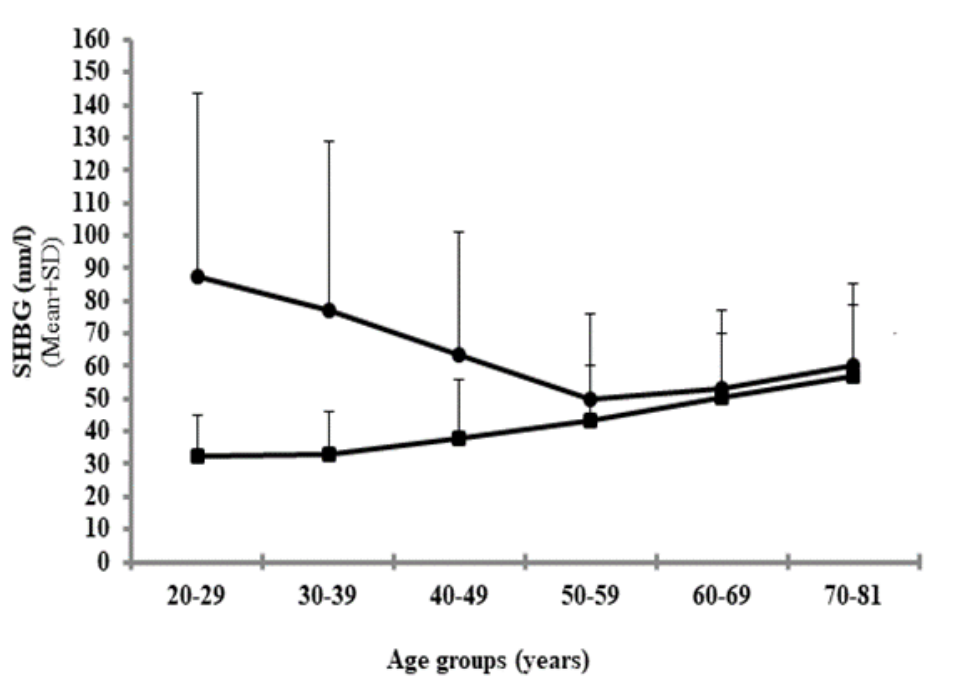
Figure 1. The linear plots indicate the geometric means of serum sex hormone-binding globulin (SHBG) levels in men ( ■ ) and women ( ● ) in decades of age 20 – 29 years, 30 – 39 years, 40 – 49 years, 50 – 59 years, 60 – 69 years, and 70 – 81 years. The Malattie Aterosclerotiche Istituto Superiore di Sanità (MATISS) study, data collected between 1993 and 1996 in Central Italy and serum SHBG levels analysed in 2016 [13 – 15].